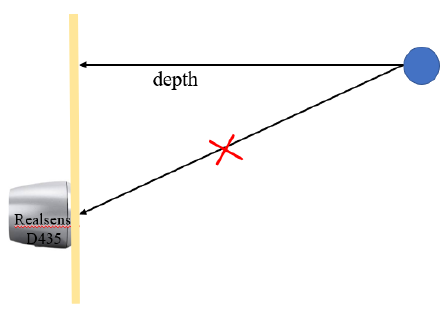
Figure 13. The meaning of depth value of the RealSense D435.